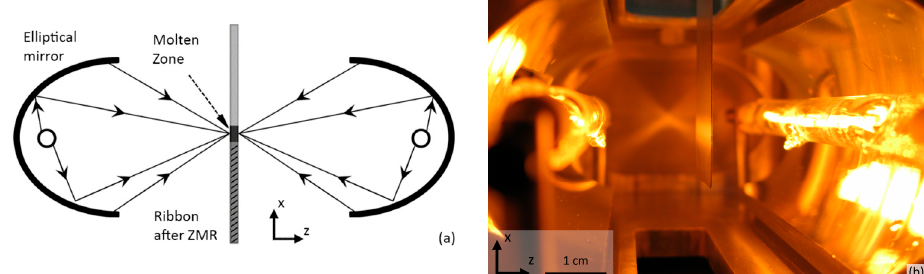
Figure 3. ZMR reactor: ( a ) schematic of the concept and ( b ) close-up photo of the interior.